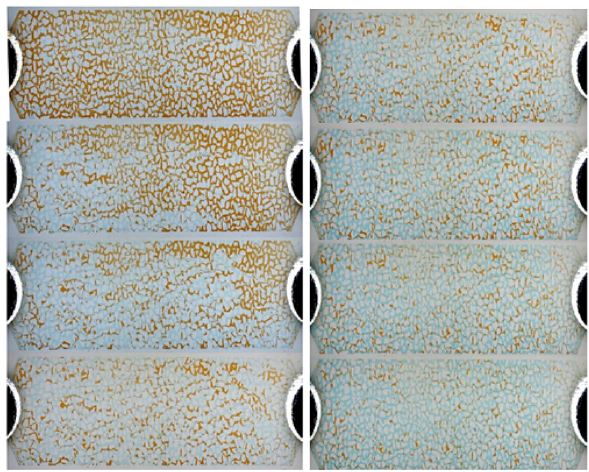
Fig. 7 Chronological progress of the primary WI followed by tertiary CWI (Mosavat 2014)